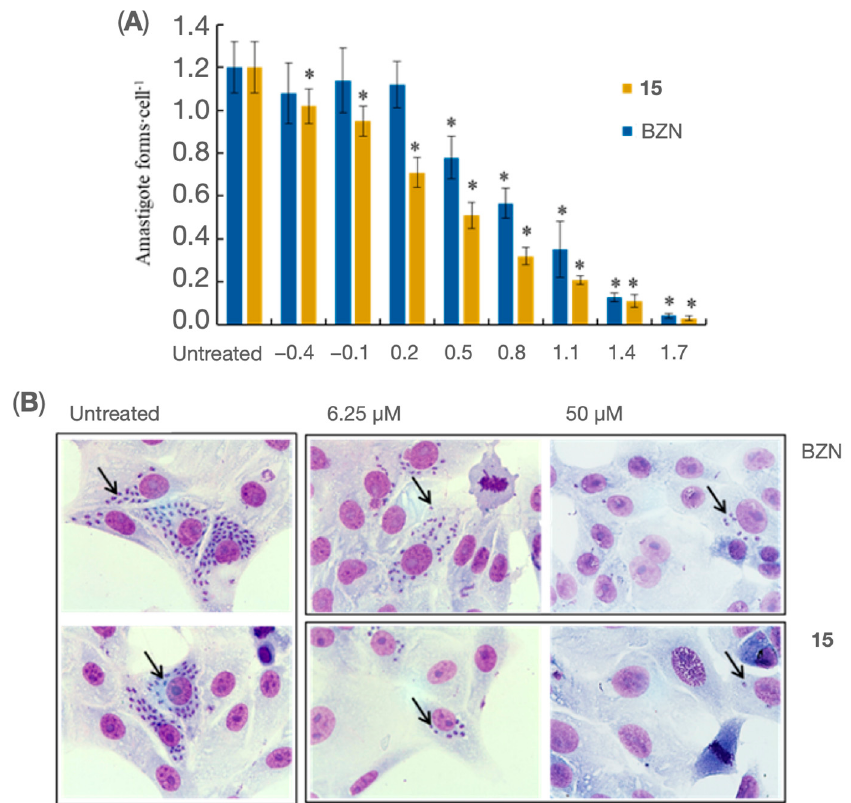
Figure 1. ( A ) Number of Trypanosoma cruzi amastigotes per Vero cell exposed to compound 15 and the reference drug benznidazole (BZN). Values are the mean of three separate determinations ± standard deviation. * Significant differences between untreated and treated amastigotes ( p < 0.05). ( B ) Representative Giemsa stained images of untreated and treated Vero cells infected. Arrows point to intracellular amastigote forms of T. cruzi Arequipa strain.